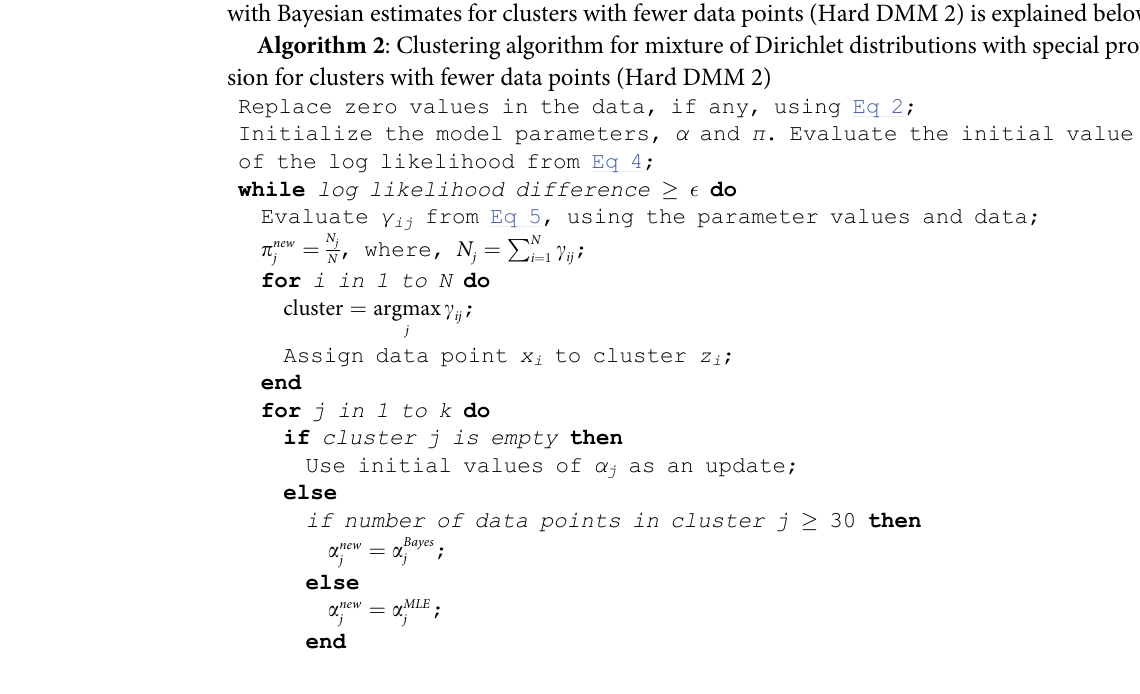
Algorithm 2 : Clustering algorithm for mixture of Dirichlet distributions with special provi- sion for clusters with fewer data points (Hard DMM